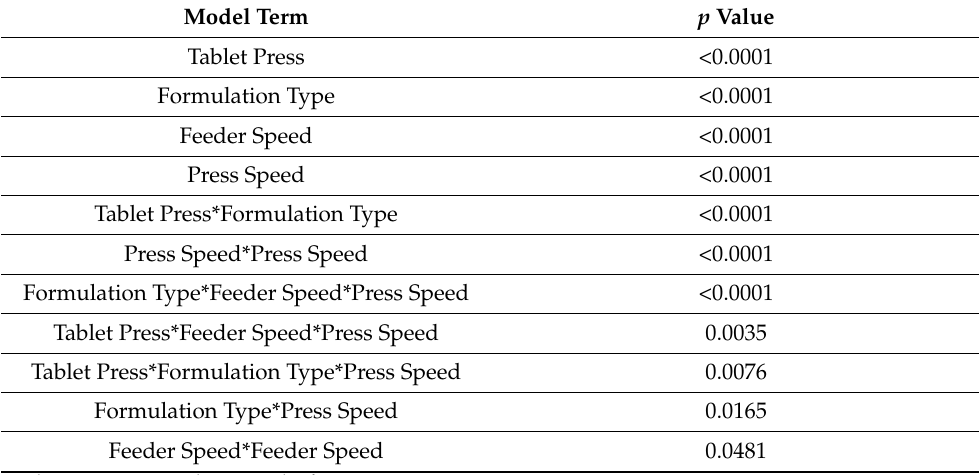
Table 4. Effect test summary of model terms (factors) and their interactions showing significant effects ( p < 0.05) on the log-transformed tablet weight variability